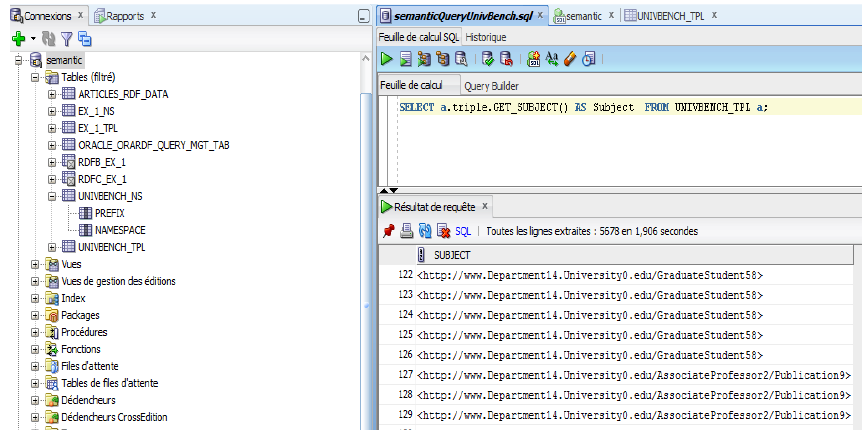
Figure 7. DW implementation in Oracle semantic